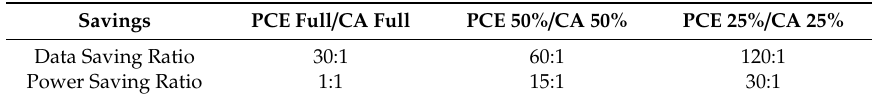
Table 1. Comparison in Data Compression Ratio and Power Saving Ratio between Three Sensing Models. Here, 30 frames are condensed to 1 coded frame.